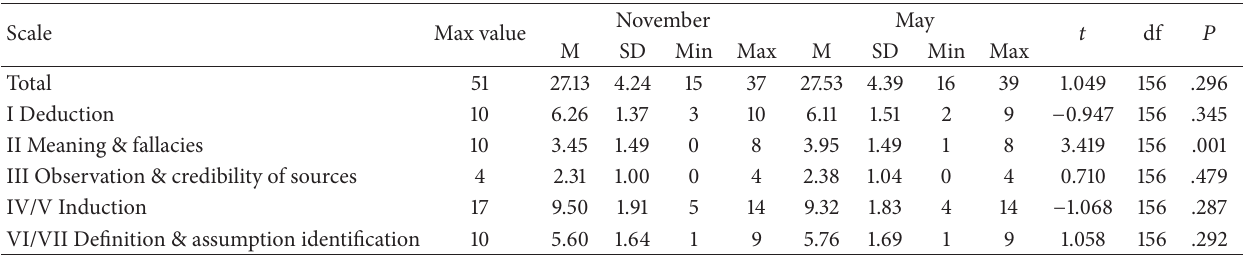
Table 3: Descriptive statistics for the CCTT ( 𝑁 = 157